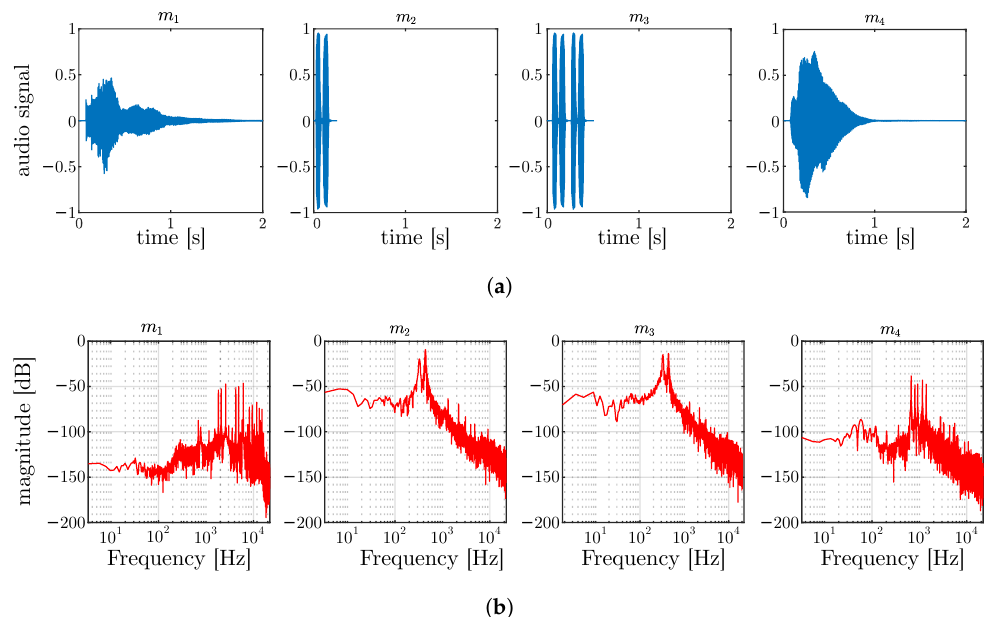
Figure 2. A visualization of the used auditory icons from m 1 to m 4 showing their corresponding waveform ( a ) and spectrogram ( b